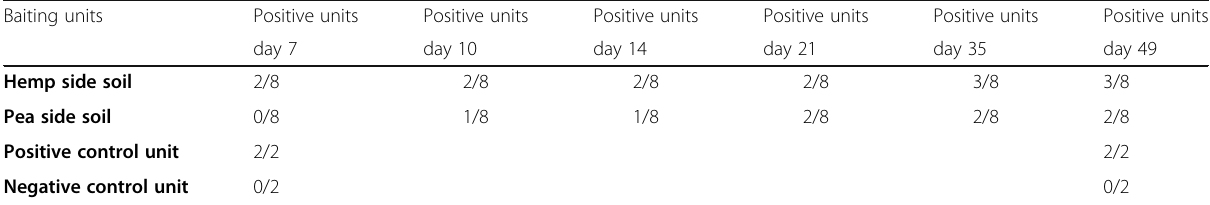
Table 4 Soil results from baiting units Baiting